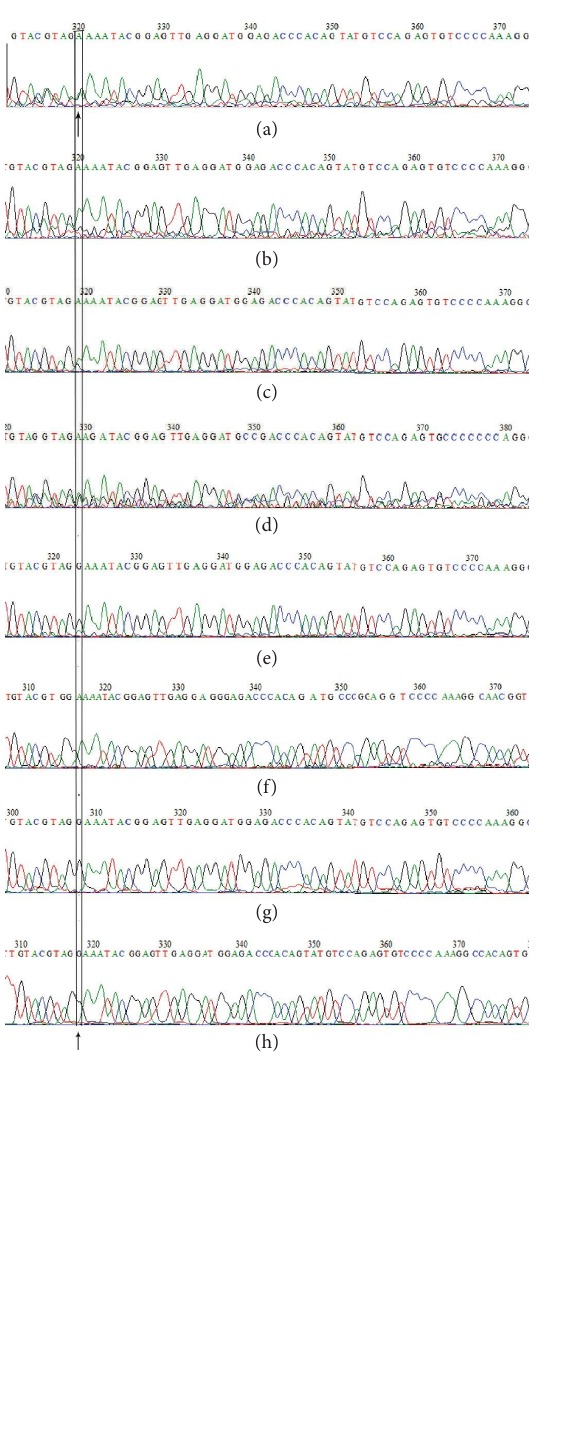
Figure 2: (a–h) Part of sequence chromatogram showing LEP rs6976701 variants in study subjects. (a) Heterozygous genotype (AG) in case (P289); (b) heterozygous genotype (AG) in obese (P286); (c) heterozygous genotype (AG) in case (P203); (d) heterozygous genotype (AG) in case (P288); (e) heterozygous genotype (AG) in case (P055); (f) homozygous genotype (AA) in case (P292); (g) homozygous genotype (GG) in control (C253); (h) homozygous genotype (GG) in case (P089). (i-j) Part of sequence chromatogram showing LEP Tr5Tr (C/G). Te missense codon is marked. (i) Heterozygous (CG) in case (P184); (j) homozygous (CC) in control (C177). (k–n) A part of sequence chromatogram showing missense mutation Phe17Leu. (k) Heterozygous (GT) genotype in case (P169); (l) homozygous genotype in control (C300); (m) heterozygous (GT) genotype in case (P202); (n) homozygous genotype (TT) in case (P116). (o–r) A part of sequence chromatogram showing missense mutation Lys 36 Arg. Te missense codon is shown in the box. AAG codes for Lys and AGG codes for Arg. (o) Homozygous AA in case (P055); (p) missense mutation AG (Lys 36Arg) in case (P171); (q) homozygous AA in control (C061); (r) homozygous AA in case